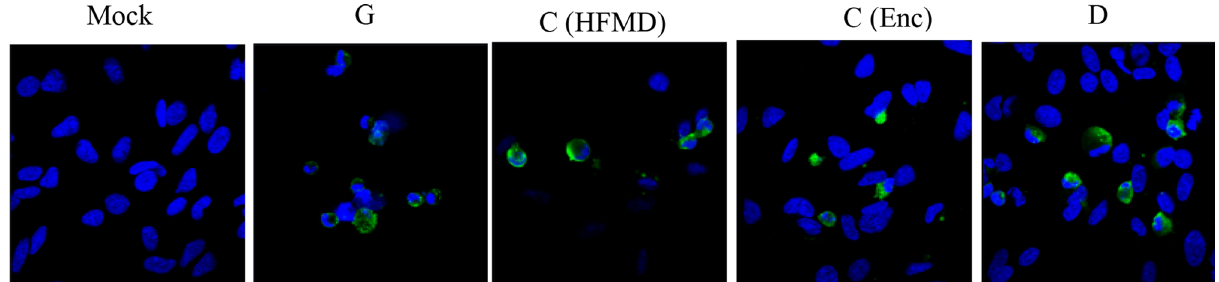
Figure 3. SK-N-SH cells were mock-infected or infected with EV-A71genotypes at an MOI of 5 for 24 h. Cells were probed with anti-EV71 monoclonal antibody and anti-mouse FITC, stained with DAPI and examined by confocal microscopy. EV-A71 (green), DAPI (blue) examined by confocal microscopy (Carl Zeiss LSM 510 Meta (63X) confocal microscope). Three independent experiments were performed, representative image of one experiment